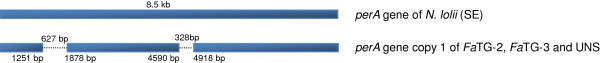
Schematic diagram of
perA
gene copy 1 of
Fa
TG-2,
Fa
TG-3 and UNS aligned with the
perA
gene sequence of
N. lolii.